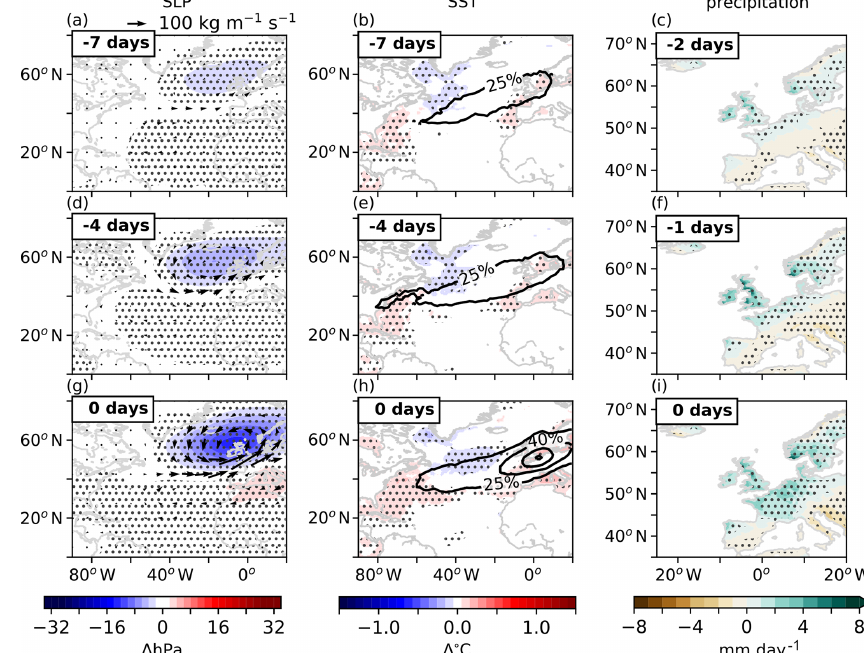
Figure 9. Anomalies of (a) SLP (colour shading) and IVT (vectors), (b) SST (colour shading) and relative number of ARs covering an area, and (c) precipitation on days with an AR over the Netherlands without the occurrence of a CE. Stippled areas indicate regions where the difference in conditions between ARs with CEs and ARs without CEs are statistical significant with a p value below 0.05 derived from a student t test comparing monthly anomalies of daily mean values during events to those of the full time